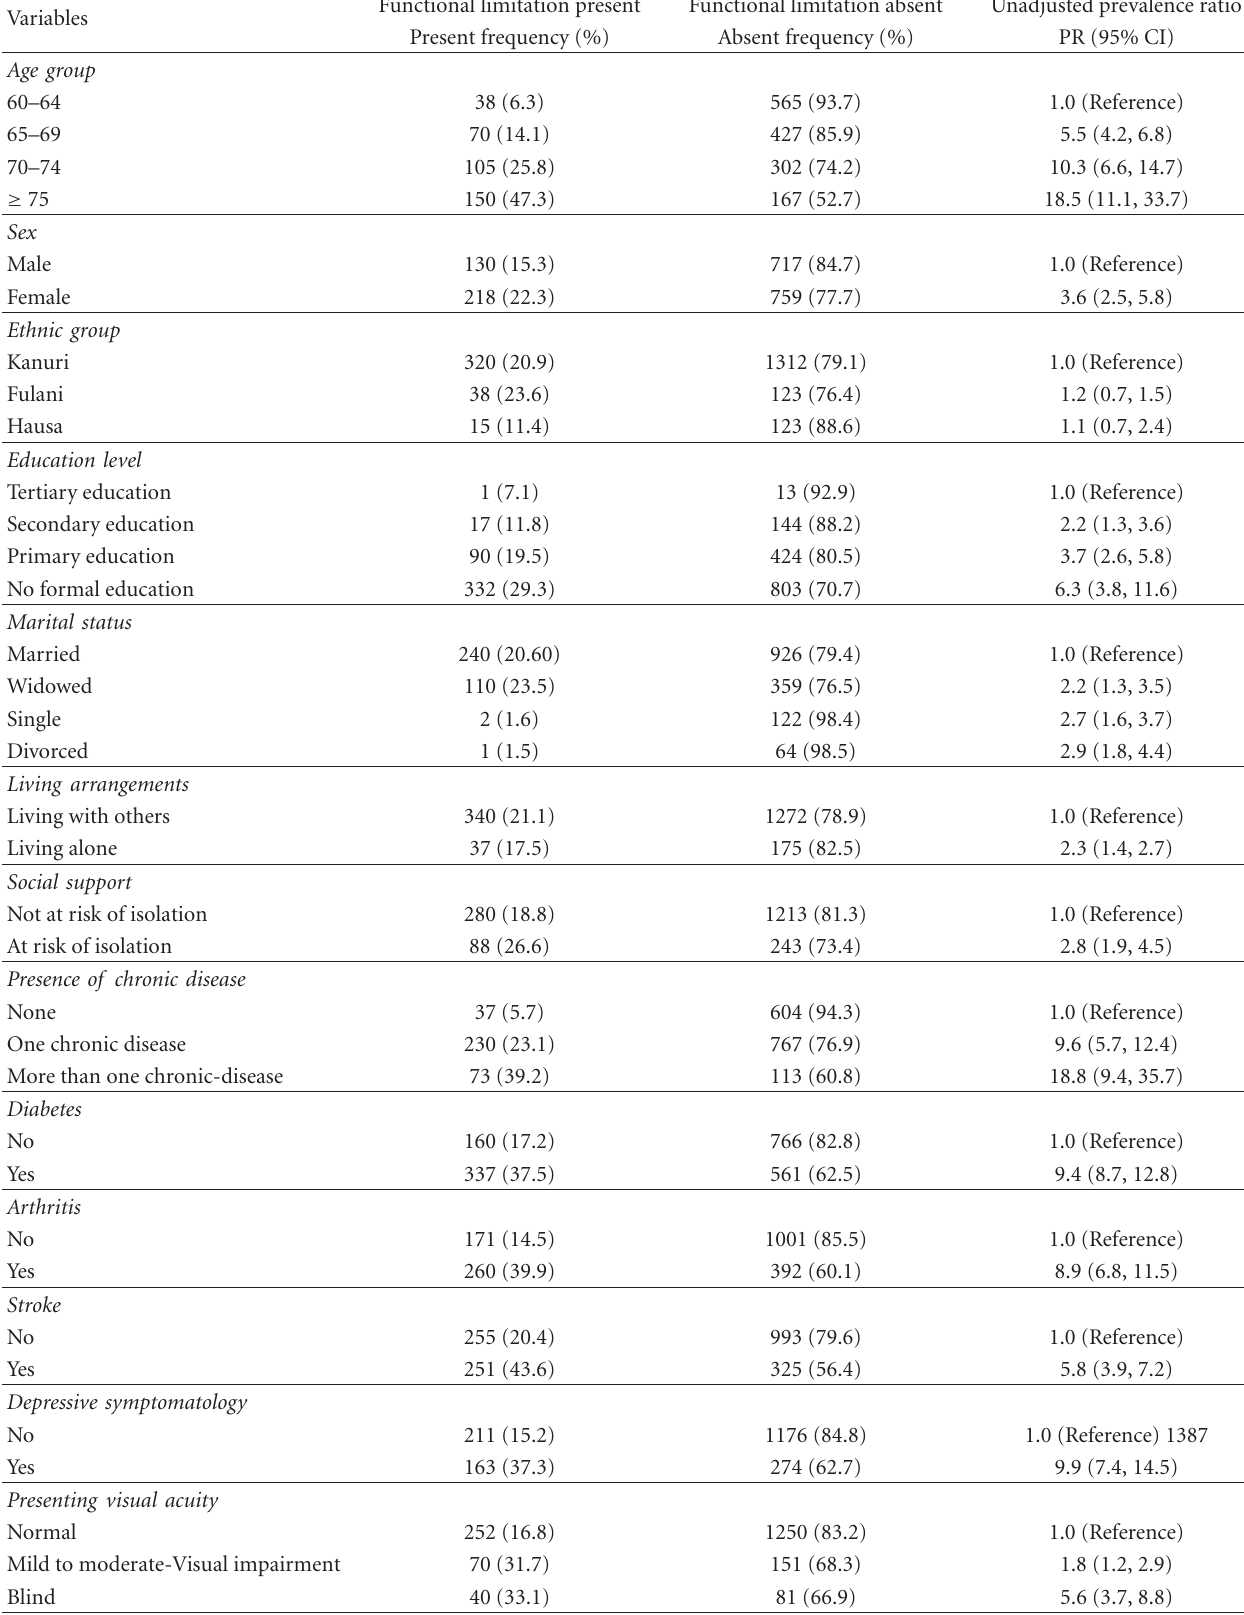
Table 4: Univariate analysis of variables associated with functional limitation